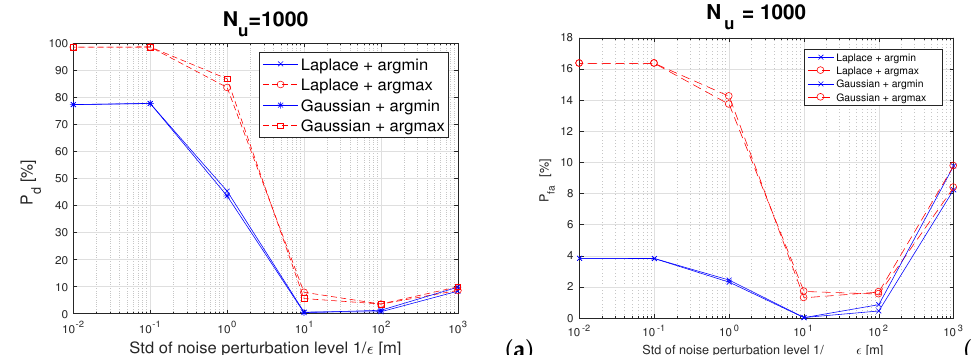
Figure 9. ( a ) Detection and ( b ) false-alarm probabilities versus the noise perturbation level for two noise types (Laplacian and Gaussian) and two mapping metrics (argmin and argmax). The proximity threshold γ was set to 2 m (e.g., for a digital contract-tracing application). A 4-floor building with 1000 users and 80% of them placed in hotspot areas.